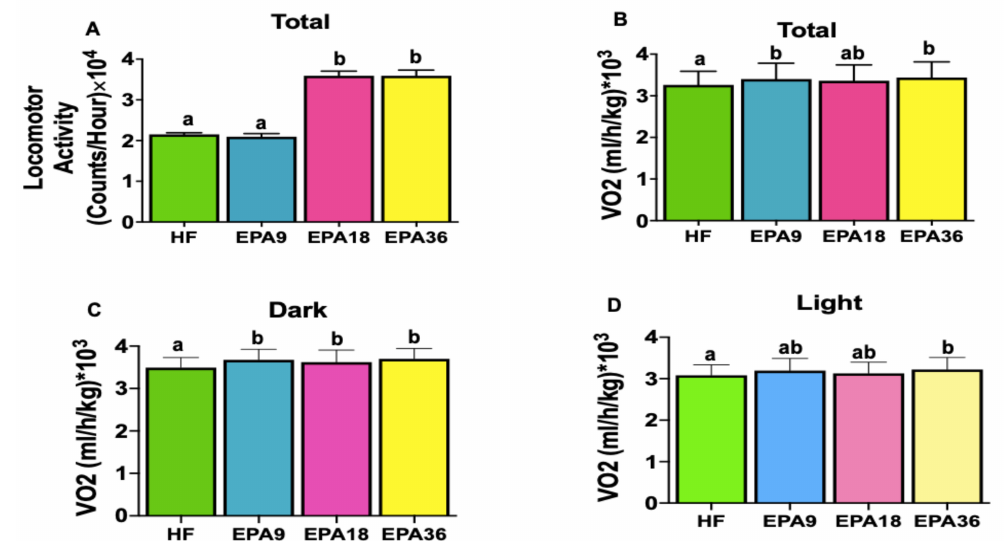
Figure 6. Dose-dependent e ff ects of EPA on locomotor activity and oxygen consumption in mice. ( A )EPA18and36significantlyincreasedtotallocomotoractivitycomparedtoHFandEPA9, ( B )EPA9and 36 significantly increased total oxygen consumption compared to HF, ( C ) EPA9, 18, and 36 significantly increased oxygen consumption compared to HF in dark, ( D ) EPA36 significantly increased oxygen consumption compared to HF in light. Data are expressed as mean ± SEM. Groups represented with same letter indicate no di ff erence. p < 0.05; n = 4 mice per group. EPA, eicosapentaenoic acid; HF, high fat.